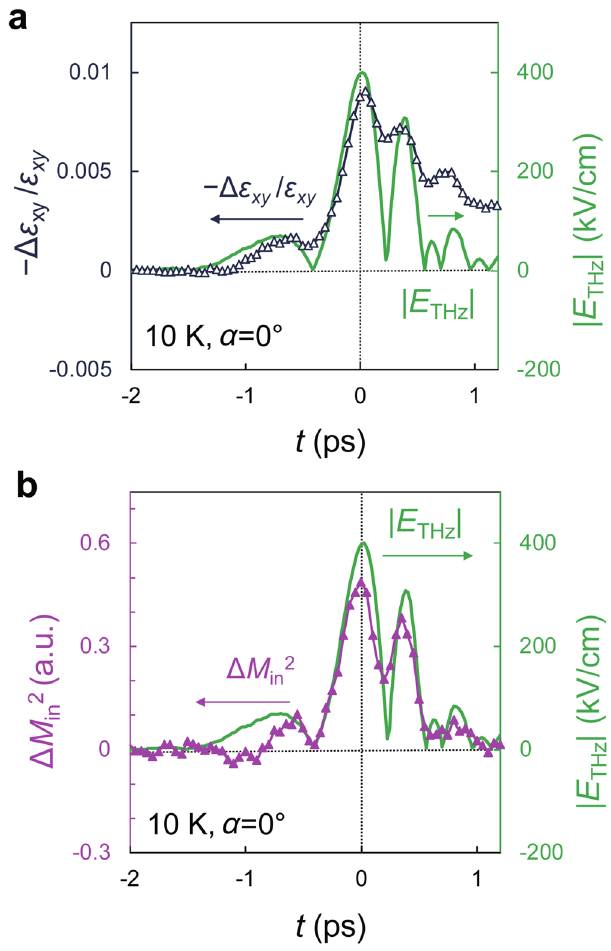
Figure 3. Magnetization modulation by E THz . ( a,b ) The time evolution of ∆ε ε − / that of Δ M in2 (purple plot in b ). | E THz | is shown by the green solid curve. Here, α is